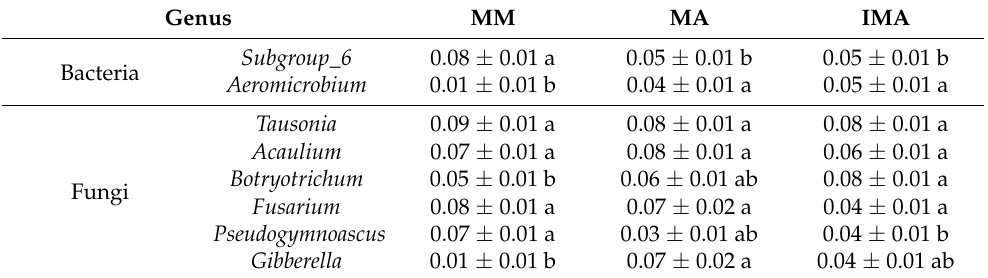
Figure 3. Relative abundance of species composition at the soil microbial genus level in different treatments. ( a ): Relative abundance of bacterial genus-level species composition; ( b ): Relative abundance of fungal genus-level species composition. MM: Morus alba ; MA: Medicago sativa ; IMA: Morus alba – Medicago sativa . Table 3. Effects of intercropping on relative abundance of genus level dominant bacteria and fungi.